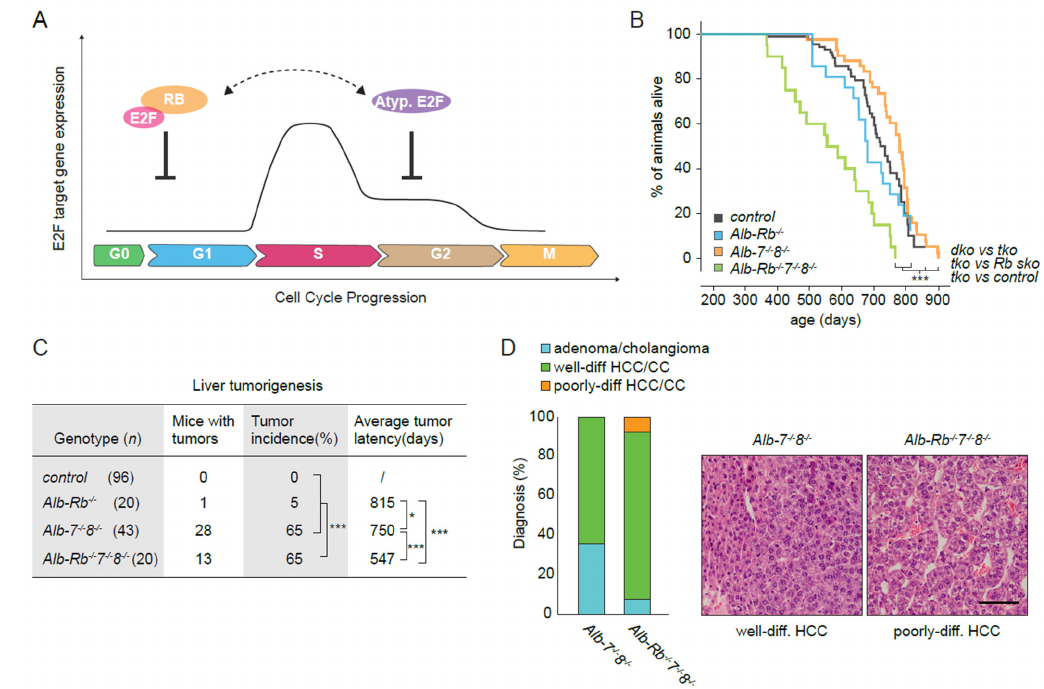
Figure 1. Atypical E2Fs and RB cooperate to prevent liver cancer. ( A ) Schematic representation of the regulation of E2F dependent transcription by RB and atypical E2Fs in the cell cycle. ( B ) Kaplan–Meier overall survival curves of control ( n = 96), Alb-Rb − / − (Rb sko; n = 20), Alb-7 − / − 8 − / − (dko; n = 43) and Alb-Rb − / − 7 − / − 8 − / − (tko; n = 20) mice. ( C ) Table indicating tumor incidence (%) and tumor latency (days) of the indicated genotypes at the end of life-span. ( D ) Histological classification of tumors from Alb-7 − / − 8 − / − ( n = 28) and Alb-Rb − / − 7 − / − 8 − / − ( n = 13) mice. In the right representative pictures of well and poorly differentiated HCC tumors. Scale bar: 50 µm. Data information: In ( B and C ); * p < 0.05, *** p < 0.001 (Log Rank Mantel-Cox test and Chi-square (tumor incidence)).